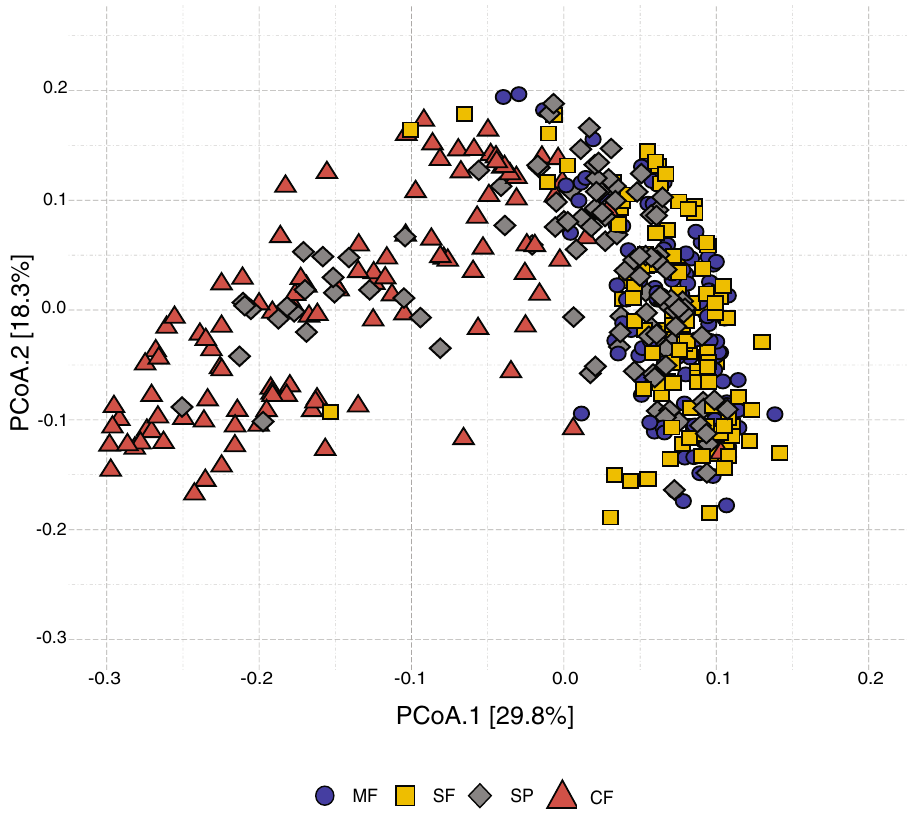
Figure 2. Community composition across sites. Principal coordinates analysis (PCoA) based on weighted UniFrac distances of stream water bacterial communities surrounded by different land uses. Community composition was determined from samples rarefied to 2100 sequences per sample. MF Mature Forest, SF Secondary Forest, SP Silvopasture, CP Traditional Cattle